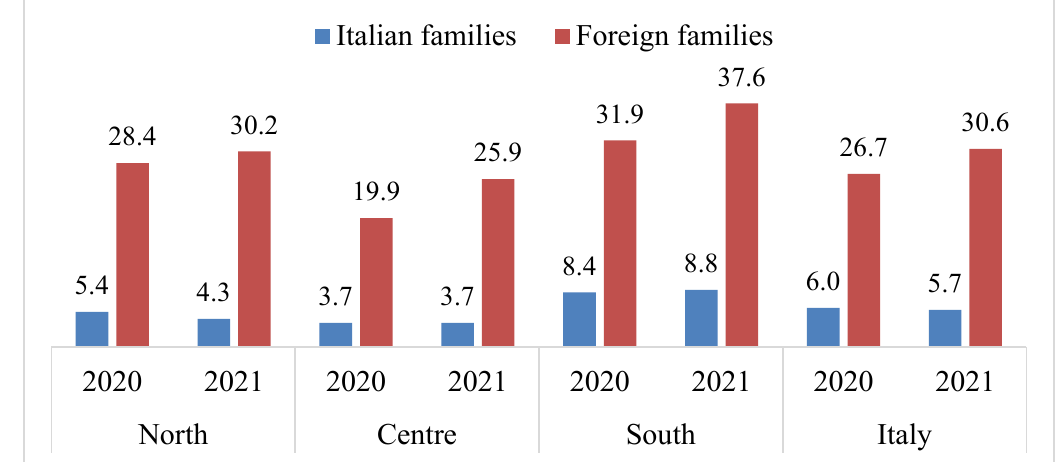
Figure 7. Poverty rate trends in Italian and foreign families, 2020–2021. Source: own elaboration on the Istat database.